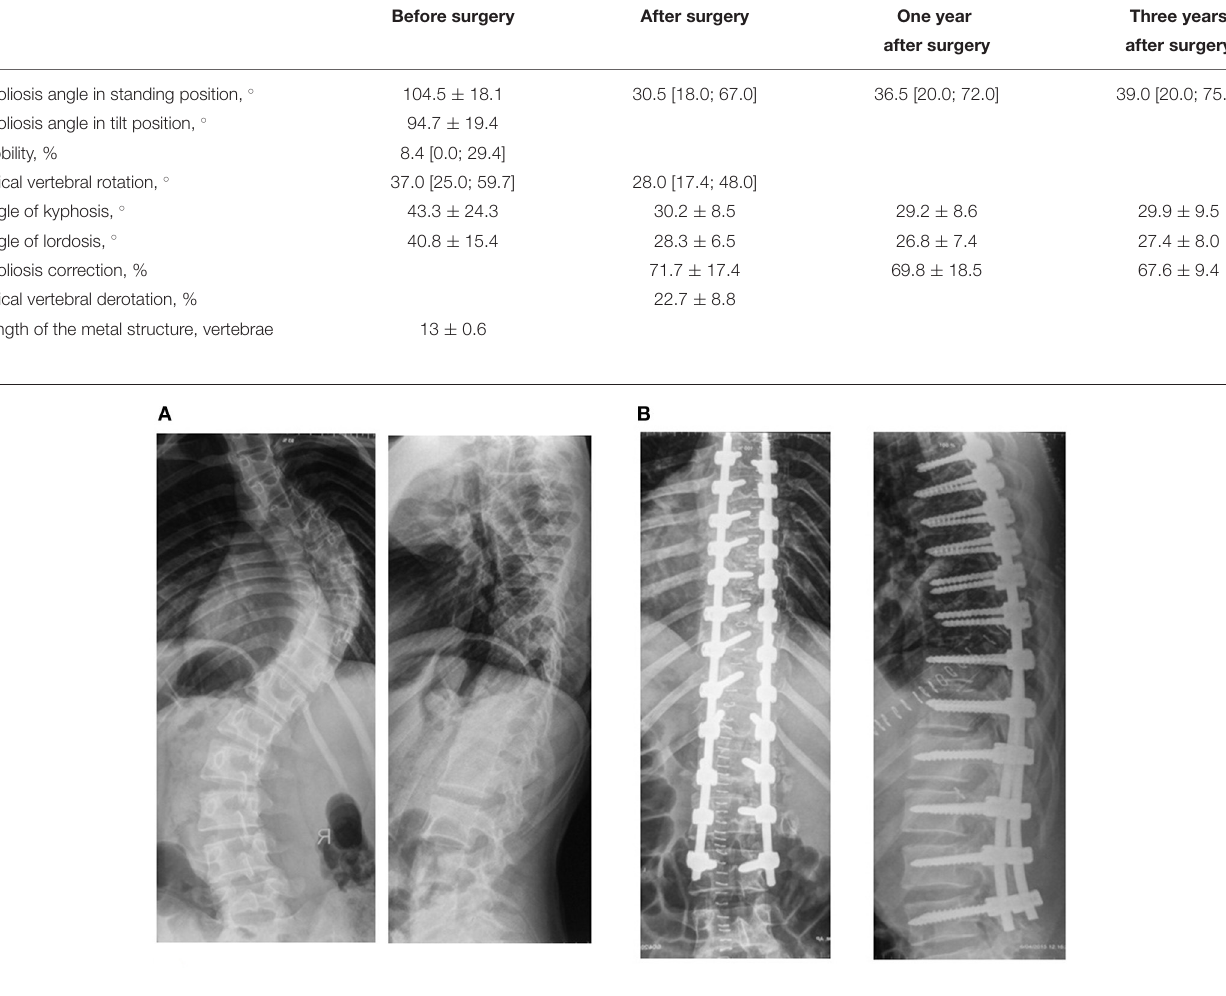
FIGURE 5 | Spinal radiographs of patient T (16 years old). Idiopathic right thoracic scoliosis. (A) Preoperatively, the angle of scoliotic deformity was 86 ◦ according to Cobb, the angle of kyphosis was 13 ◦ , and the angle of lordosis was 22 ◦ . (B) Postoperatively, the angle of scoliosis was 5 ◦ , the angle of kyphosis was 22 ◦ , and the angle of lordosis was 26 ◦